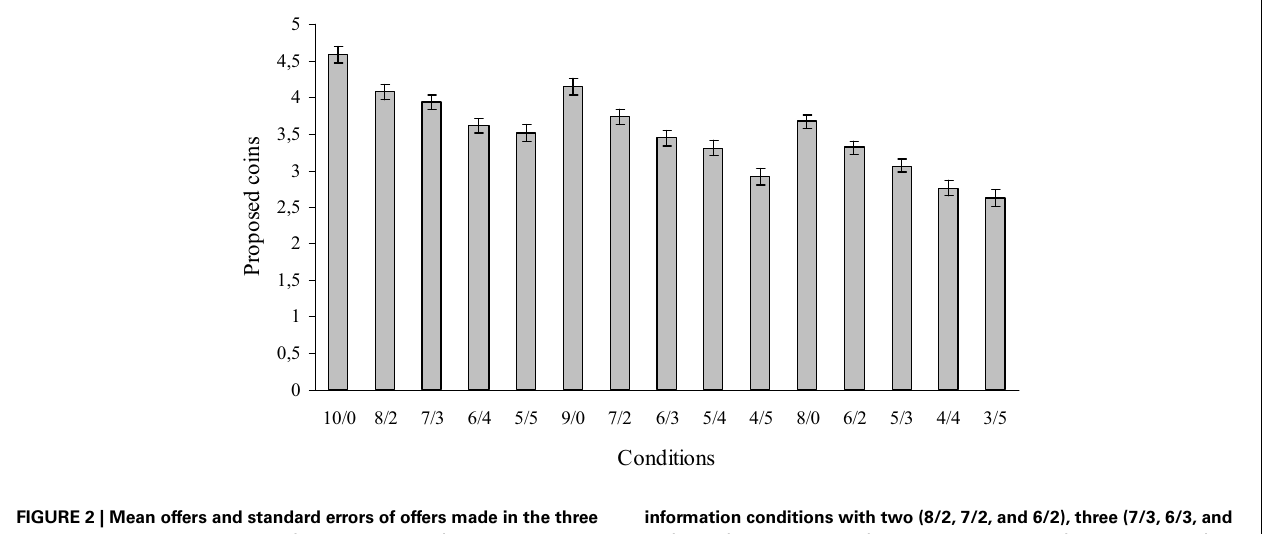
FIGURE 2 | Mean offers and standard errors of offers made in the three complete information conditions (10/0, 9/0, and 8/0) and the 12 hidden